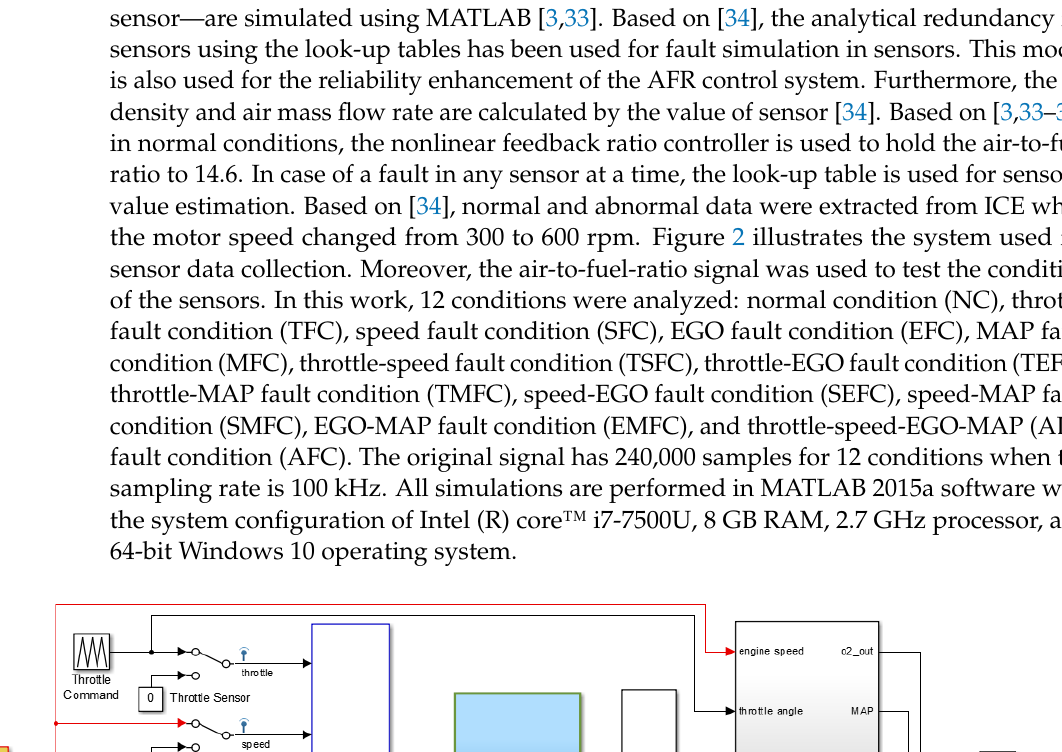
Table 1. States of sensors in the ICE.